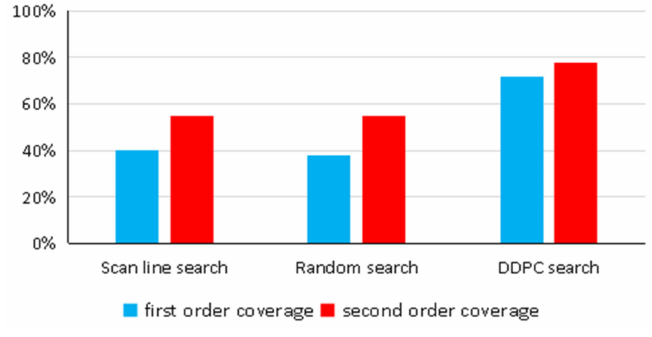
Figure 14. Regional coverage.